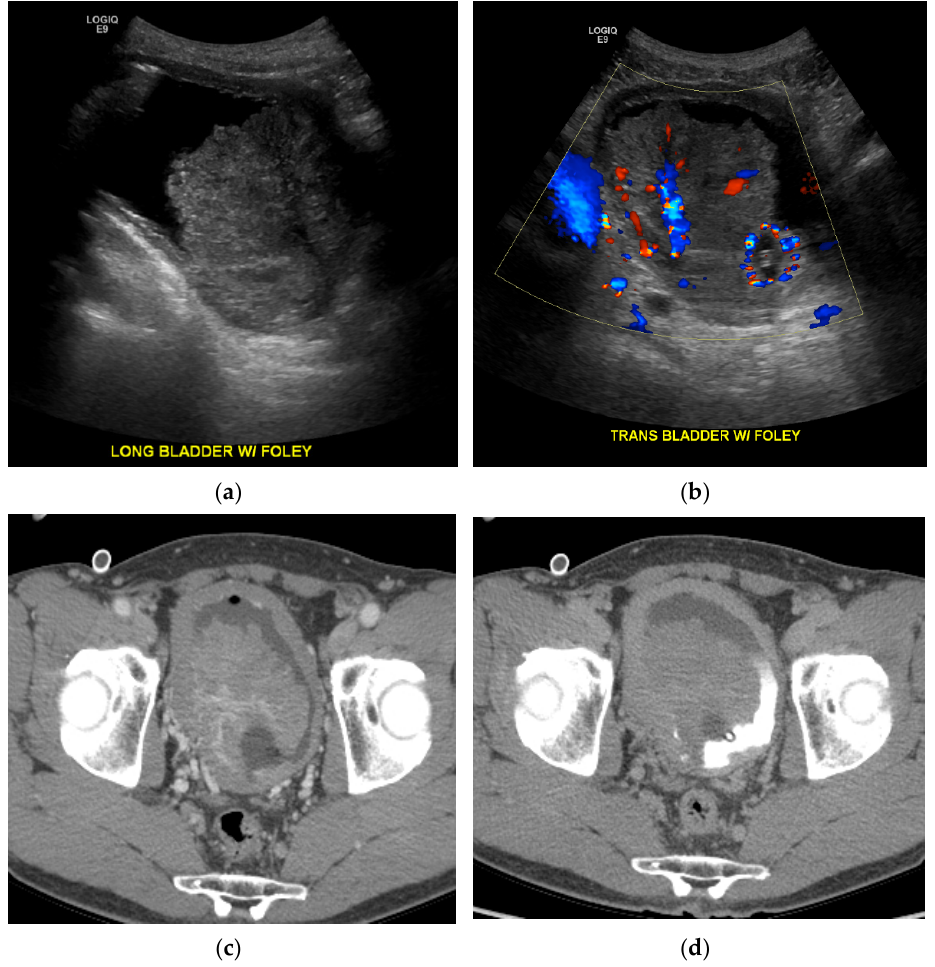
Figure 8. Ultrasound and CT images of non-muscle invasive bladder cancer . ( a ) Longitudinal grayscale ultrasound image of the bladder shows a large mass within the bladder. ( b ) Transverse color Doppler image shows vascularity within the mass. ( c ) Axial portal venous phase CT image shows a central area of enhancement, similar to the color Doppler ultrasound image. ( d ) Axial delayed phase CT image shows the mass partially surrounded by excreted contrast in the bladder.